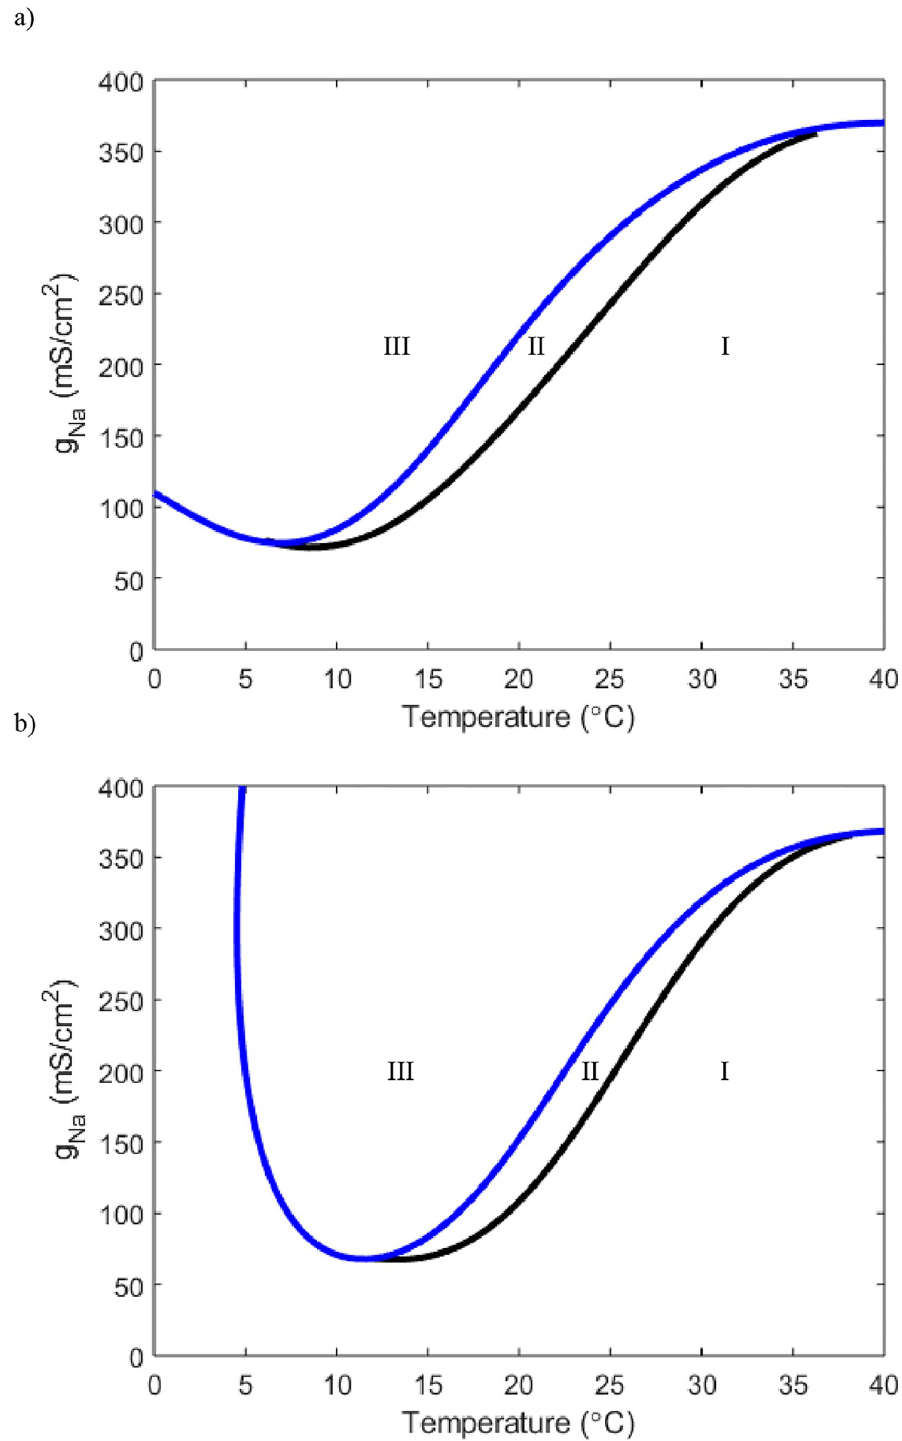
Fig 14. Two parameter bifurcations showing the relationship between temperature and g Na . In the top plot g m 8 = 3 and in the bottom g m 8 = 10. Both g l and g K are set to Hodgkin-Huxley values. Curve color and region meaning is equivalent to those in Fig 1.